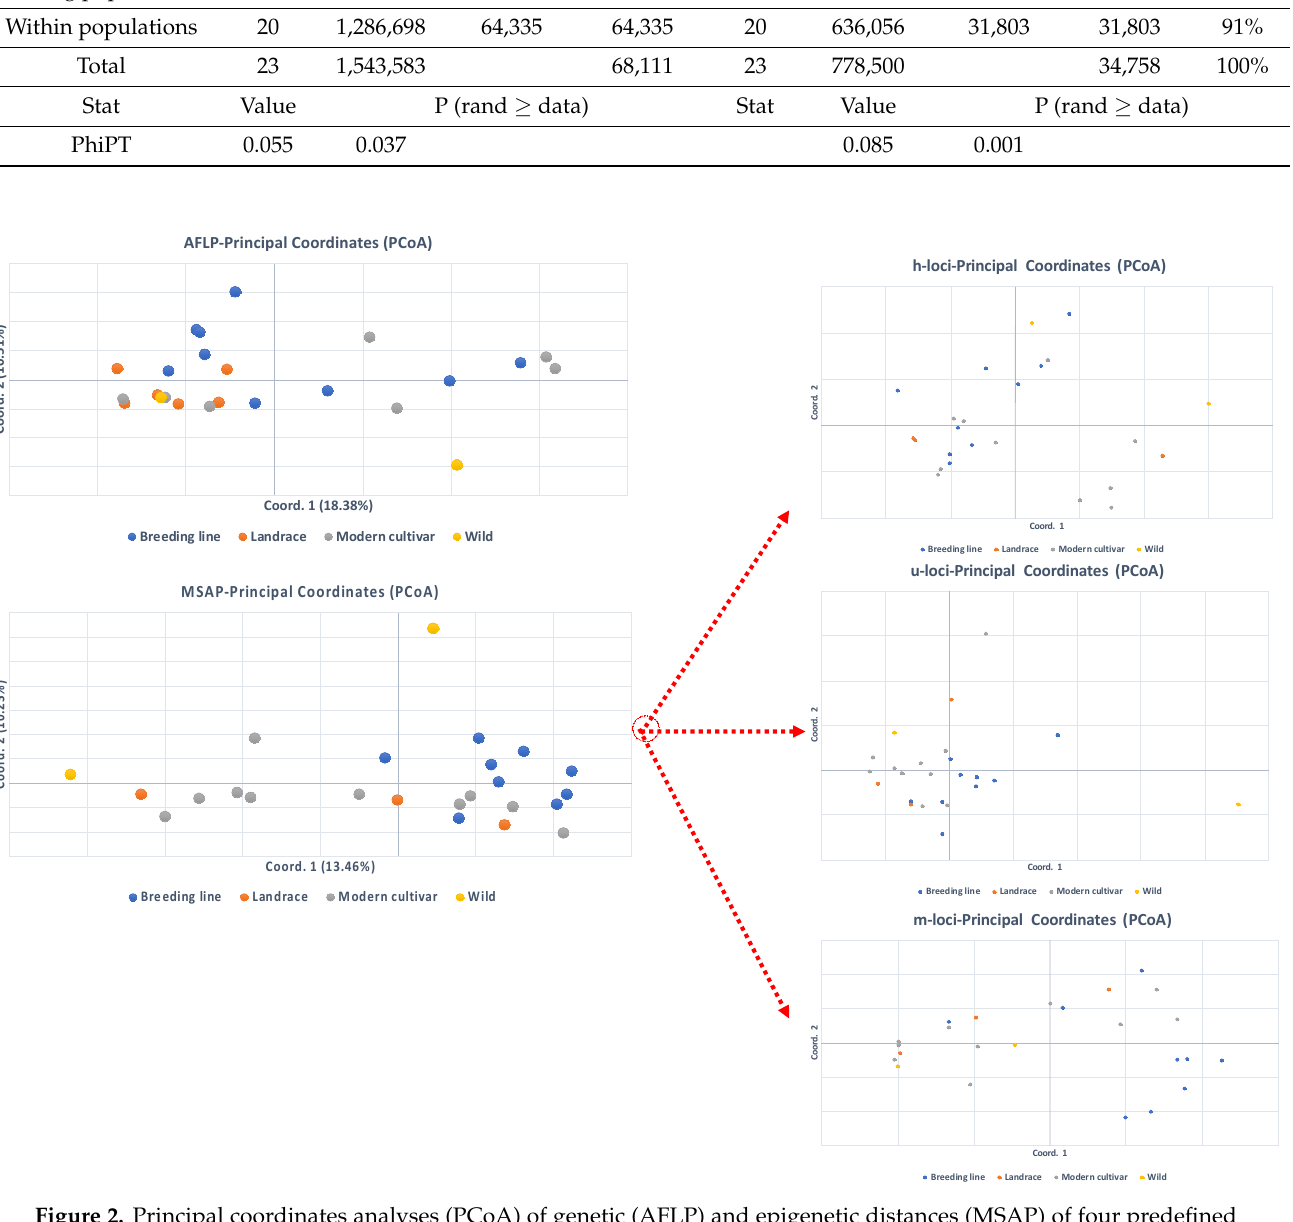
Figure 2. Principal coordinates analyses (PCoA) of genetic (AFLP) and epigenetic distances (MSAP) of four predefined populations of Prunus avium . Epigenetic data were partitioned into the three distinct methylation types, that is, unmethylated (u), CHG-hemimethylated (h) subepiloci, and CG-methylated (m). Table 3. Intra-population ( A ) genetic and ( B ) epigenetic variation. PLP (%): percentage of polymorphic loci (PLP gen ) and epiloci (PLP epi ). h: Nei’s genetic diversity (h gen ) and epigenetic diversity (h epi ). I: Shannon’s information index of genetic diversity (I gen ) and epigenetic diversity (I epi ). CV: coefficient of variation. A. Genetic Variation B. Epigenetic Variation